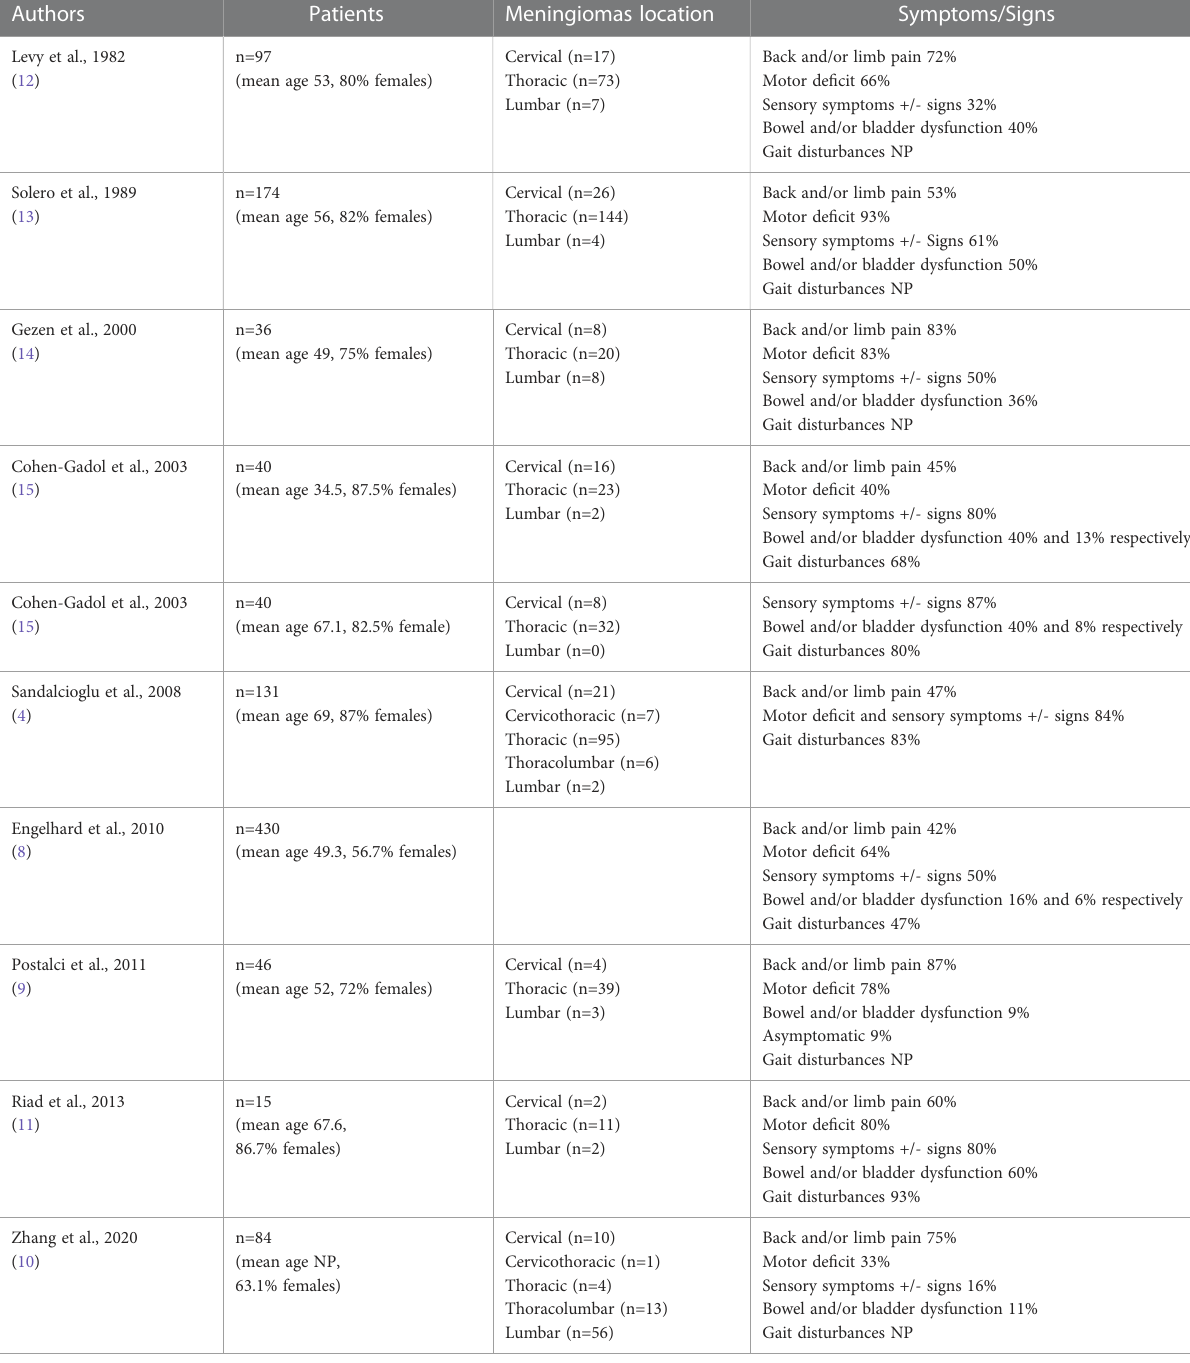
TABLE 1 Summary of clinical manifestations in spinal